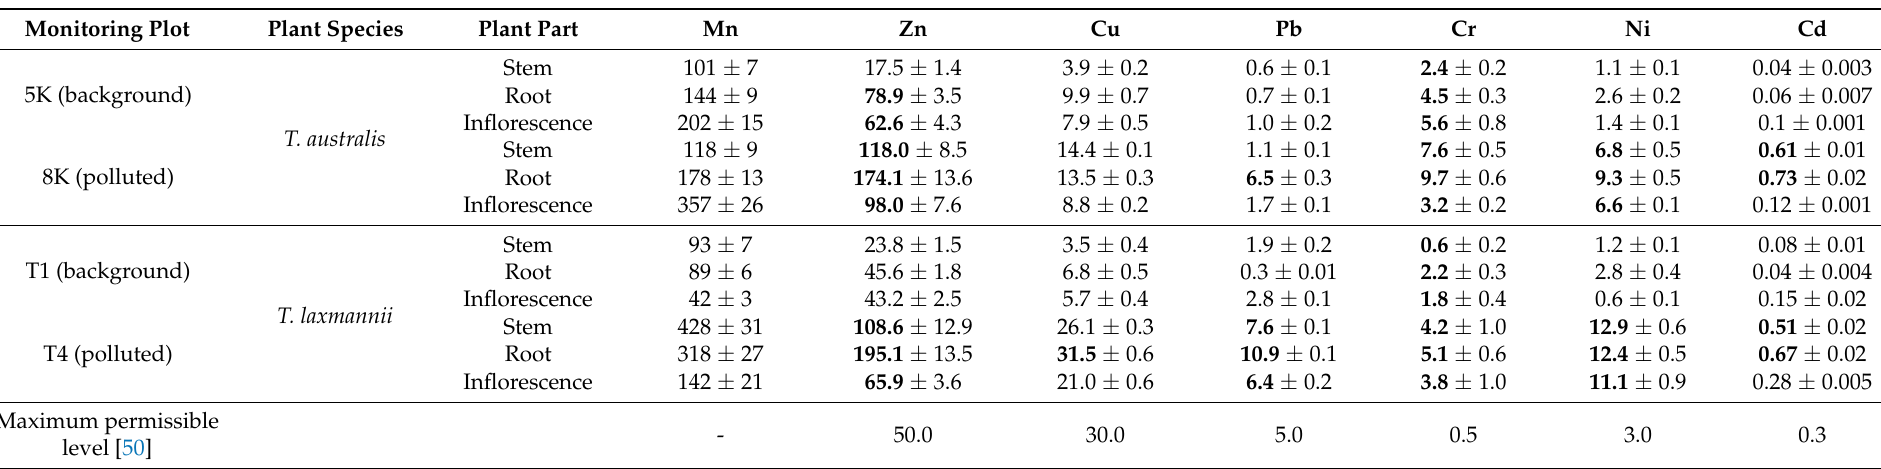
Table 2. Content of Mn, Zn, Cu, Pb, Cr, Ni and Cd (mg/kg DW) in plant parts of T. australis and T. laxmannii at the monitoring plots in the Don River delta. Monitoring Plot